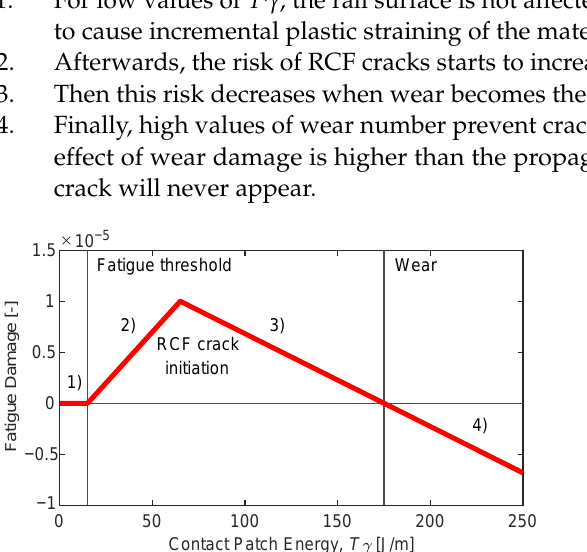
Figure 2. Rail rolling contact fatigue damage function for normal grade rails. Values are taken from